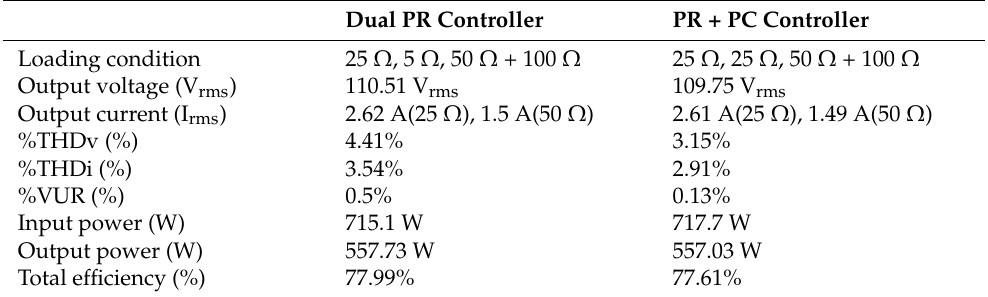
Table 1. Measurement data of the dual PR and PR + PC controlled VSIs under the unbalanced and nonlinear loading test.